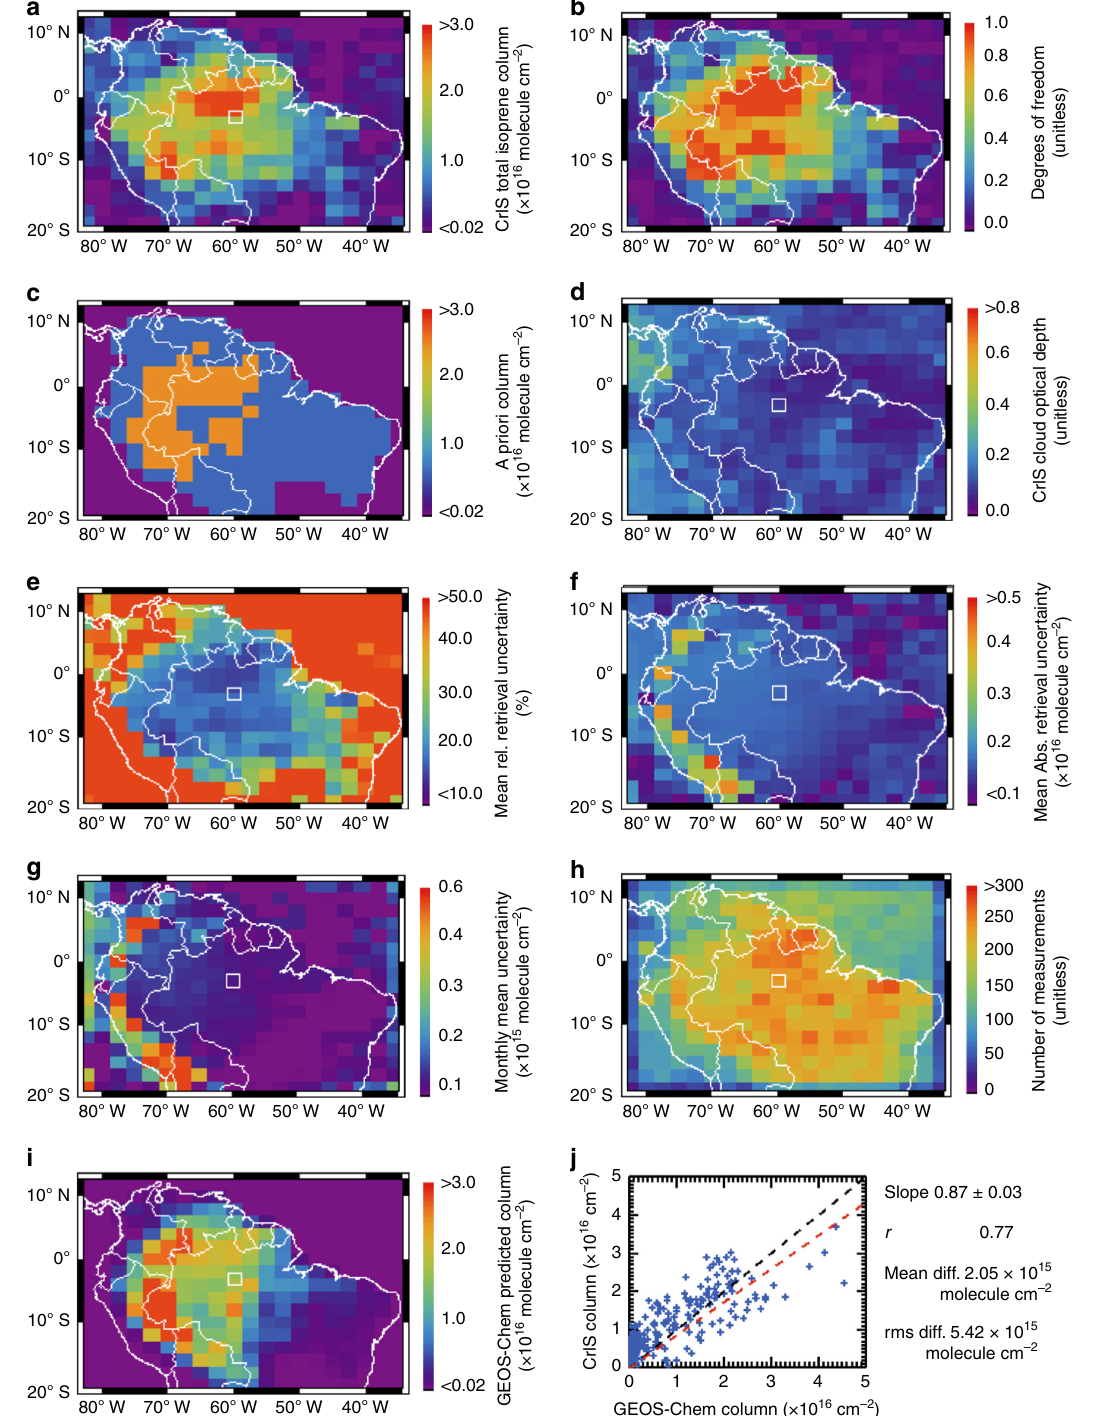
Fig. 5 CrIS isoprene retrievals over Amazonia during September 2014. The white rectangle in panels a – i depicts the study domain for the airborne Green Ocean Amazon (GoAmazon) campaign during the same month. Data in panels a – i are mapped on a 2.0° × 2.5° latitude – longitude grid. a Isoprene column densities retrieved from CrIS. b Degrees of freedom for signal in the CrIS measurements. c A priori isoprene columns used in the retrievals. d Retrieved cloud optical depths. e Mean relative retrieval uncertainty (%). f Mean absolute retrieval uncertainty (10 16 molecule cm − 2 ). g Uncertainty in the monthly ffiffiffi p n mean isoprene columns (retrieval uncertainty divided by ; 10 15 molecule cm − 2 ). h Number of CrIS measurements per grid cell. i Isoprene column densities predicted by the GEOS-Chem model for the same period. j Correlation between the CrIS and GEOS-Chem isoprene column densities. The red dashed line shows the satellite:model linear fi t, while the black dashed line indicates the 1:1 relationship